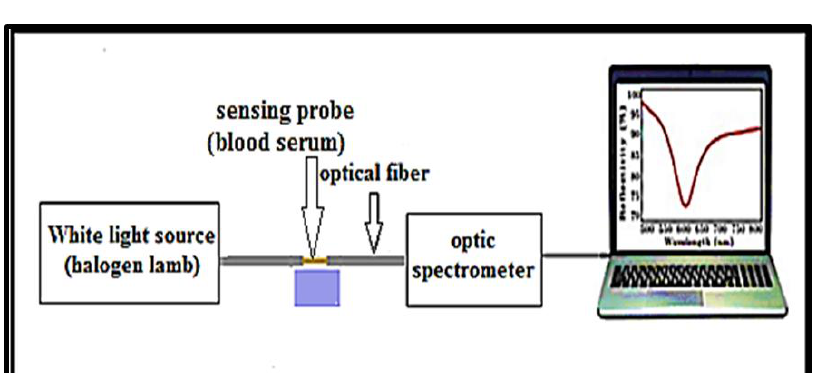
Fig.1: The experimental setup of SPR fiber optic sensor.